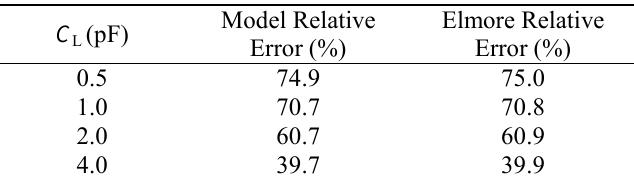
Table 6: Relative error between the 50%-propagation delay computed with the proposed model and the Elmore versus load C L for the case 1.